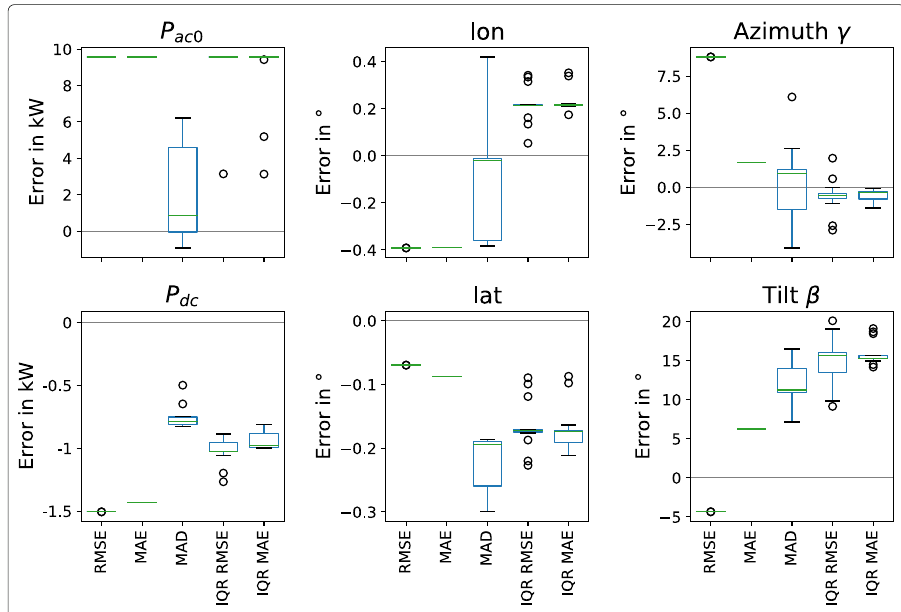
Fig. 6 Mismatch between the estimated and actual parameters (15 repetitions). Parameters search space according to Table 3. Inverter peak power P ac 0 is mostly optimised to the search space boundary, the remaining parameters are within the search